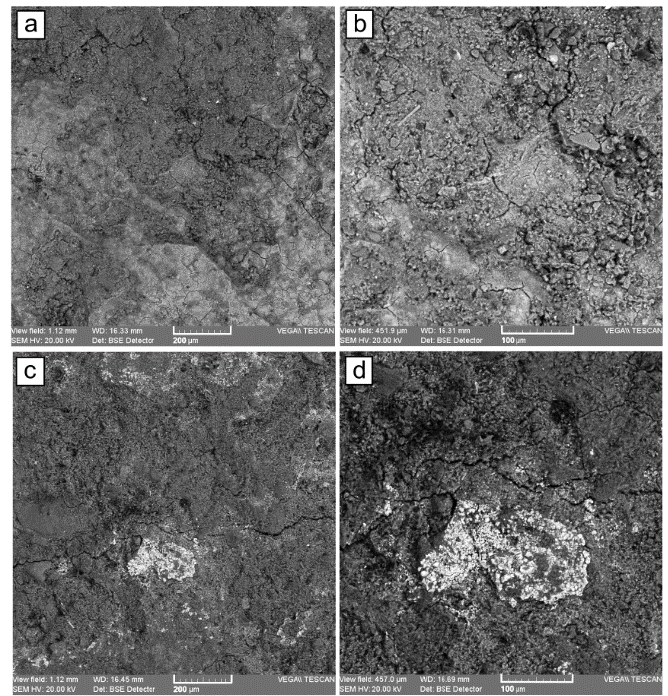
Figure 8. SEM micrographs for the pigment from Bâtca Doamnei : ( a , b ) interior; ( c , d ) exterior (( a , c ) 200× magnification; ( b , d ) 500× magnification).